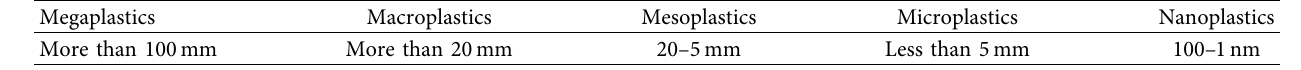
Table 1: Classifcation of plastic particles based on physical